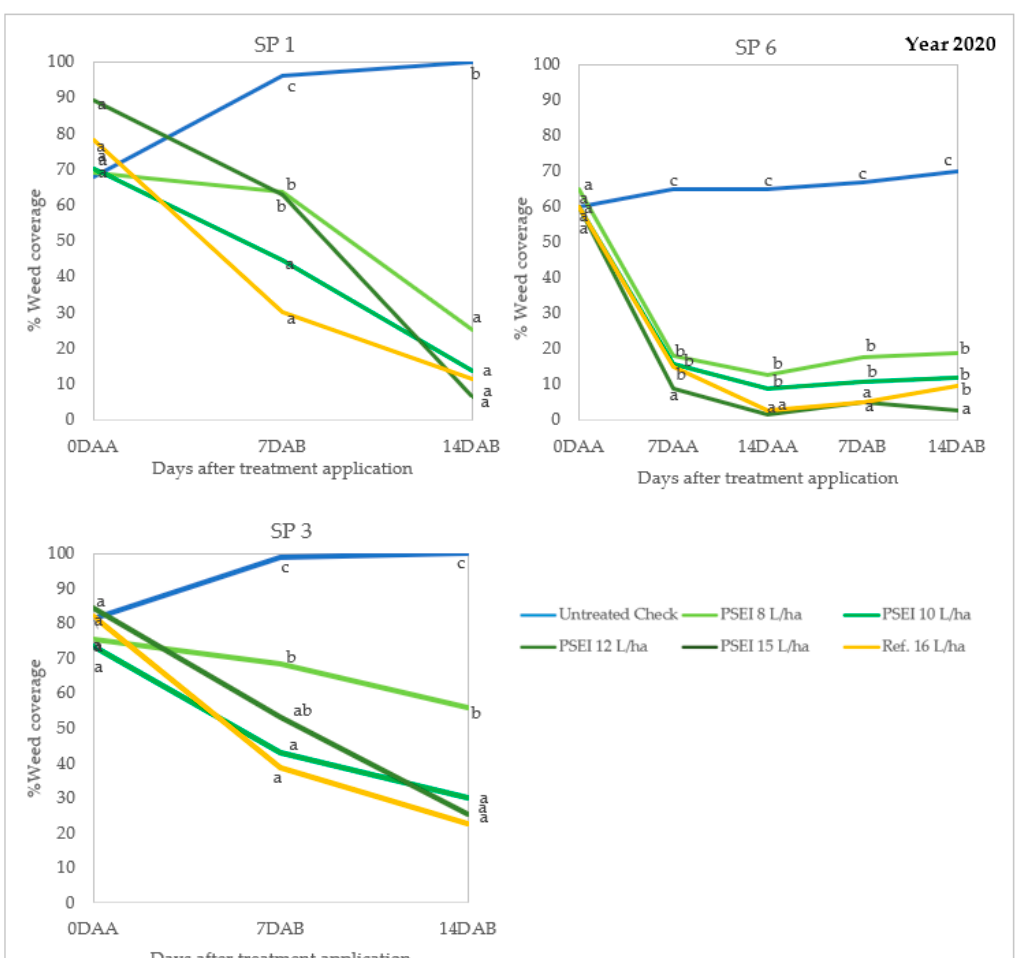
Figure 5. Percentage of weed coverage evolution during 2020 vineyard trials in Spain: SP 1 in Galicia, SP 6 in Albacete, and SP 3 in Valencia region. Evaluations of % of weed coverage per plot were performed before treatment (0DAA), 7 and 14 days after the first treatment application (7DAA and 14 DAA), and 7 and 14 days after the second treatment application (7DAB and 14 DAB). Four doses of PSEI (8, 10, 12, and 15 L/ha or 4400, 5500, 6600, and 8250 g of a.s. per ha, respectively) were evaluated compared to untreated check control and PA reference at 16 L/ha (10,880 g of a.s. per ha). Different letters in the same assessment point indicate significant differences between treatments ( p < 0.05).